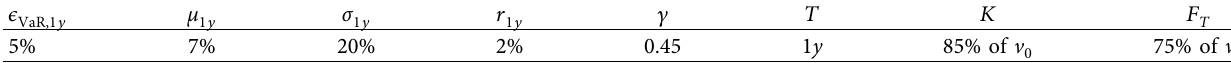
Table 2: Default parameters for the sensitivity